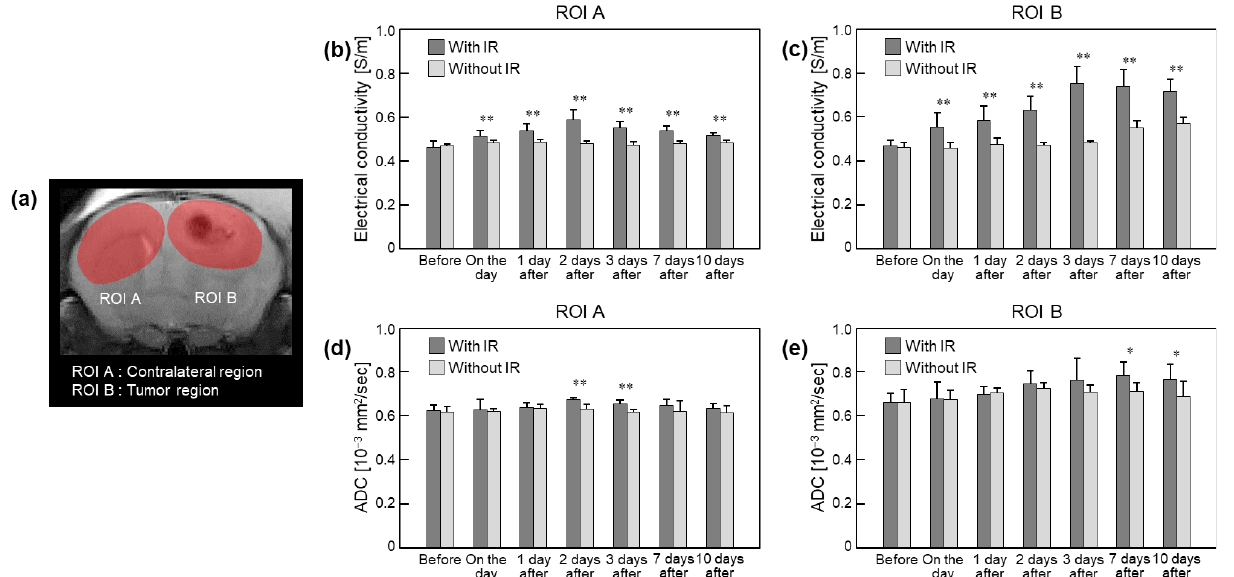
Figure 4. Comparison of absolute conductivity and apparent diffusion coefficient (ADC) in brain tissues with and without irradiation. ROIs ( a ) were located in the contralateral and tumor regions at full time points. Bar graphs indicate measured absolute conductivity ( b , c ) and corresponding ADC ( d , e ) values at ROIs before and after irradiation. Statistical significances were compared between irradiated and non-irradiated groups (* p < 0.05, ** p < 0.01). Table 1. Summary of absolute conductivity and percentage changes (in parentheses) obtained from in vivo brain tumor conductivity images. Conductivity values indicate tissue response to irradiation at a full time-course dataset. Percentage changes indicate the degree of tissue response to irradiation based on values pre-irradiation.